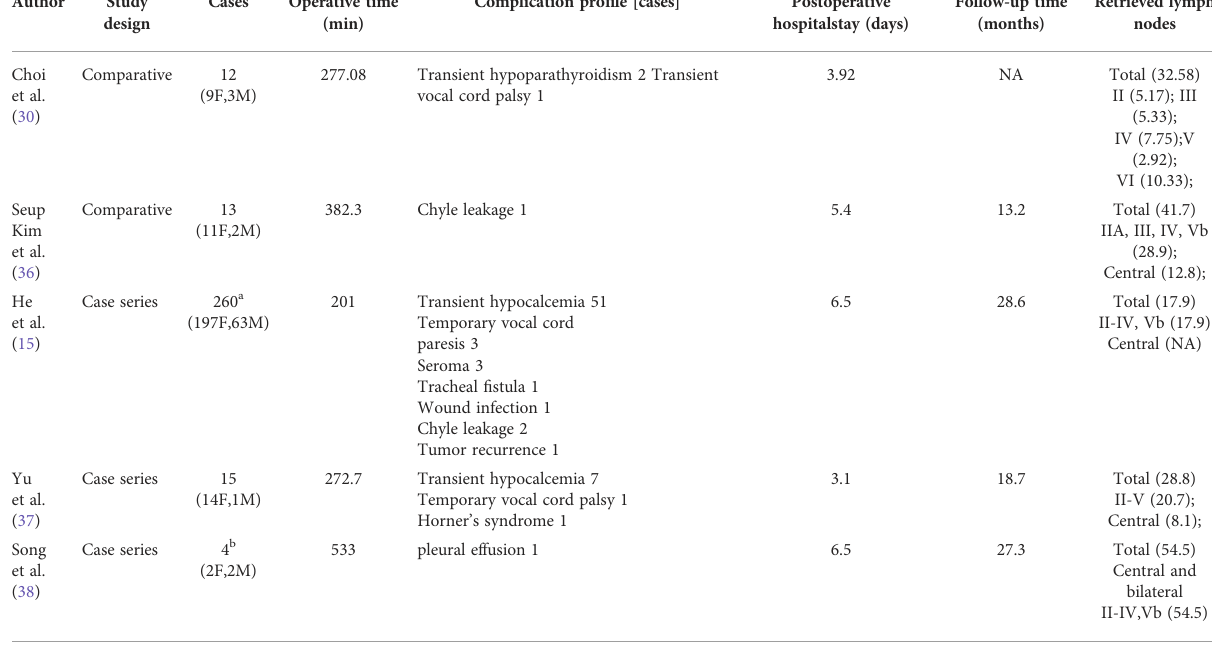
TABLE 4 Summary of studies of robotic BABA LND.